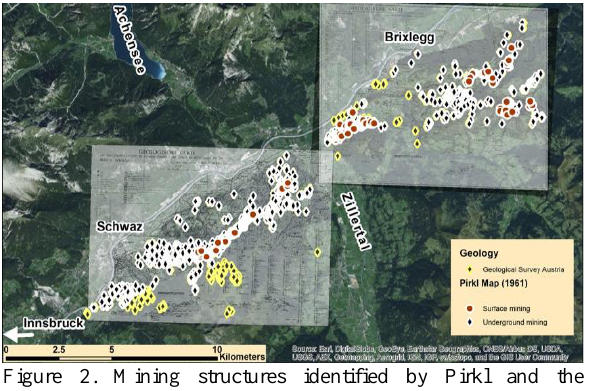
Figure 2. Mining structures identified by Pirkl and the Geological Survey Austria (source: GBA, 2014)